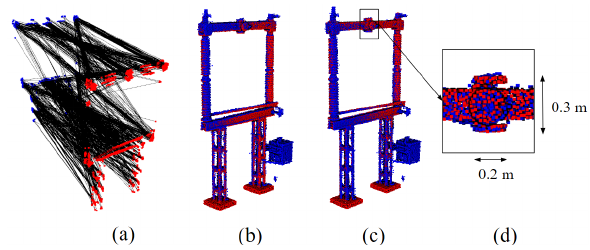
Figure 9d : our keypoint extractor caught this very specific zone allowing the right pose estimation. We compute the intersection